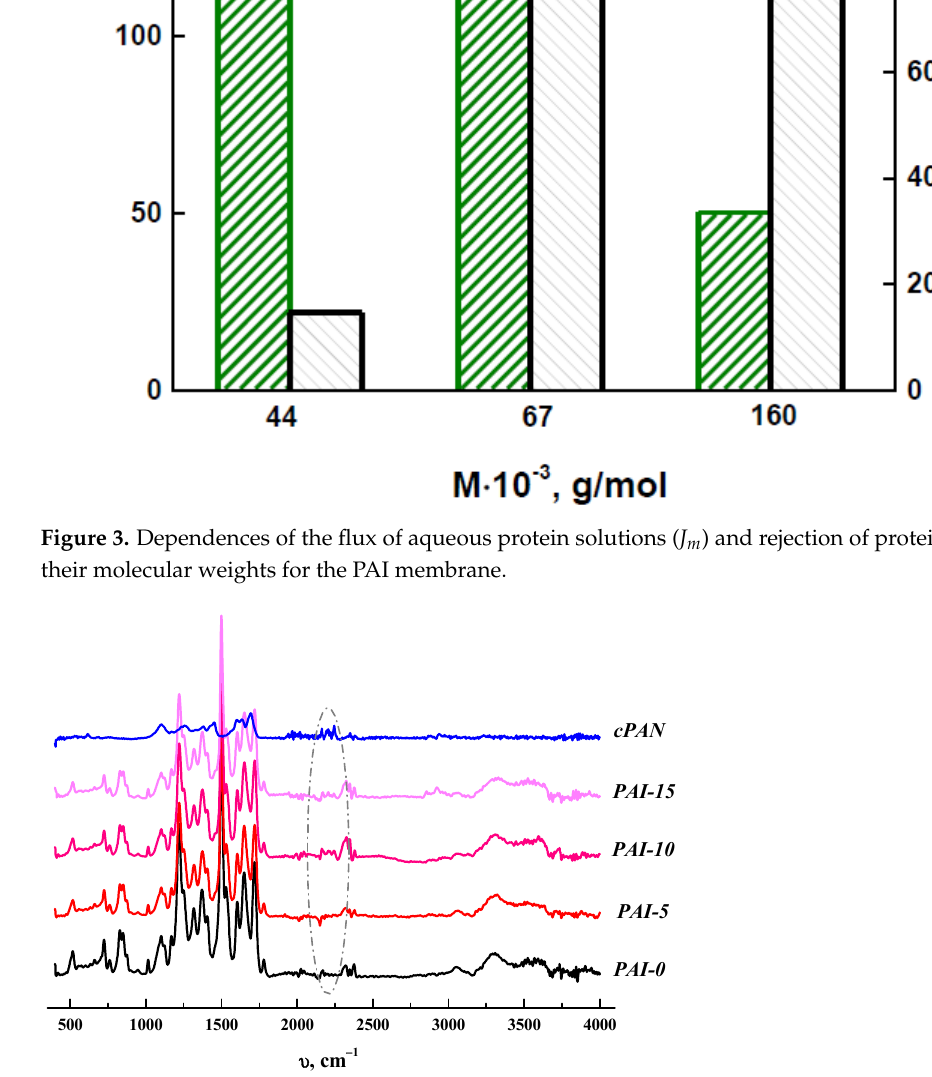
Figure 4. ATR-FTIR spectra of c PAN, PAI-0, PAI-5, PAI-10, and PAI-15.